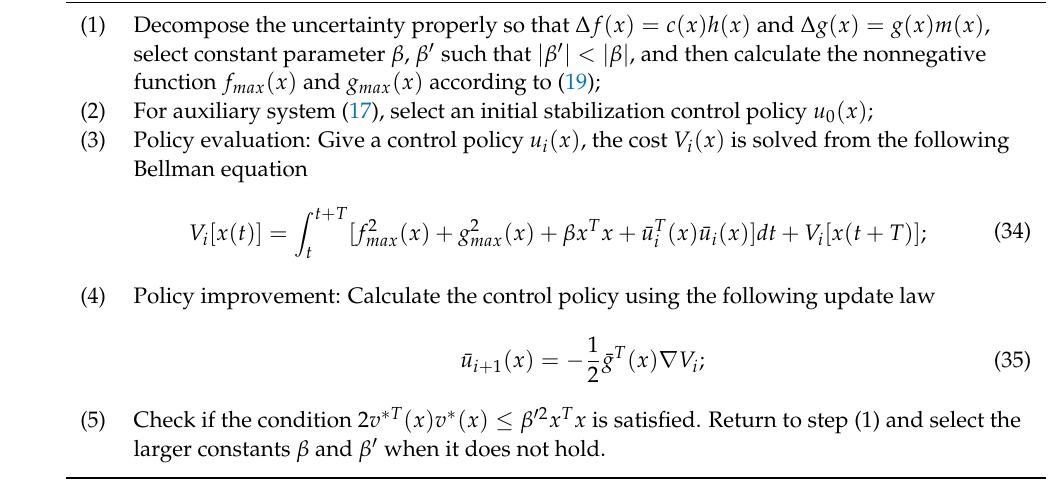
Algorithm 2 PI algorithm of robust control for nonlinear systems with mismatched